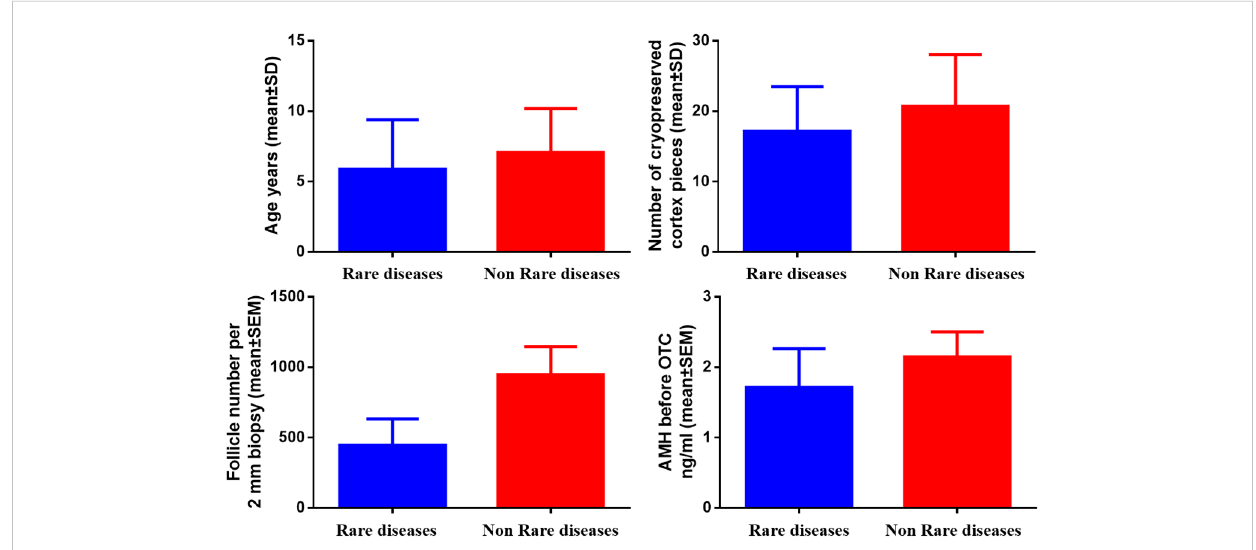
FIGURE 2 Comparison of age, number of cryopreserved cortex pieces, follicle number per 2 mm biopsy, and AMH in children with and without rare diseases.